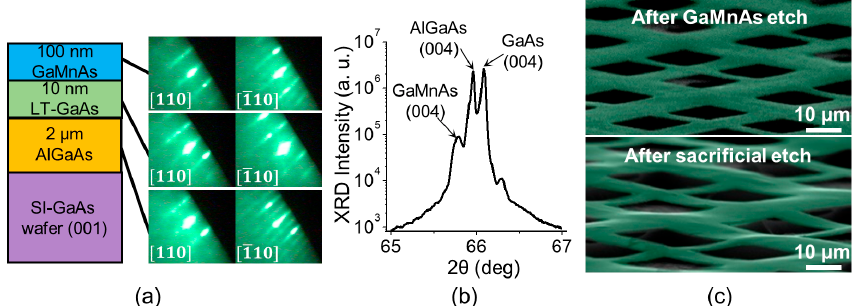
Figure 1. ( a ) GaMnAs/LT-GaAs/AlGaAs/SI-GaAs structure and corresponding RHEED images. ( b ) HR-XRD θ – 2 θ measurement of the sample. ( c ) Scanning electron microscope (SEM) images of GaMnAs crosses after the GaMnAs etch ( top ) and after the sacrificial etch ( bottom ), which show buckling of the GaMnAs epilayer after the removal of the underlying AlGaAs sacrificial layer. GaMnAs layer is distinguished with added false color (green).